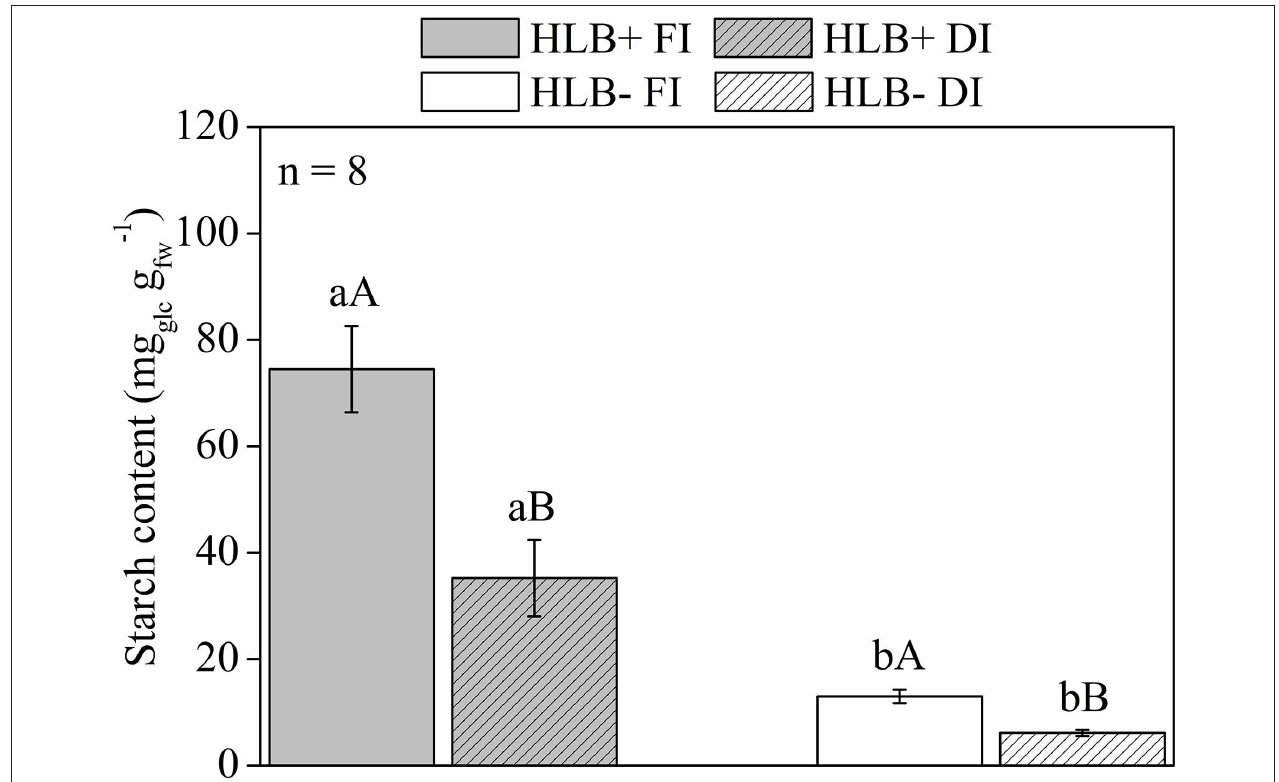
FIGURE 7 | Starch content of leaves of “Valência” orange trees [ Citrus sinensis (L.) Osbeck] grafted on citrumelo “Swingle” rootstock [ Citrus paradisi Macfad. x Poncirus trifoliata (L.) Raf.] either infected with “ Ca . Liberibacter asiaticus” ( + ) or healthy (–) and exposed to two water management treatments: fully irrigated (FI) and deficit-irrigated (DI). Values are mean ± SE ( n = 8). Means followed by the same letter do not differ between water management treatments within the same HLB infection conditions (upper case) or between HLB infection conditions within the same water management treatment (lower case) according to unpaired Student’s t -test at 5%